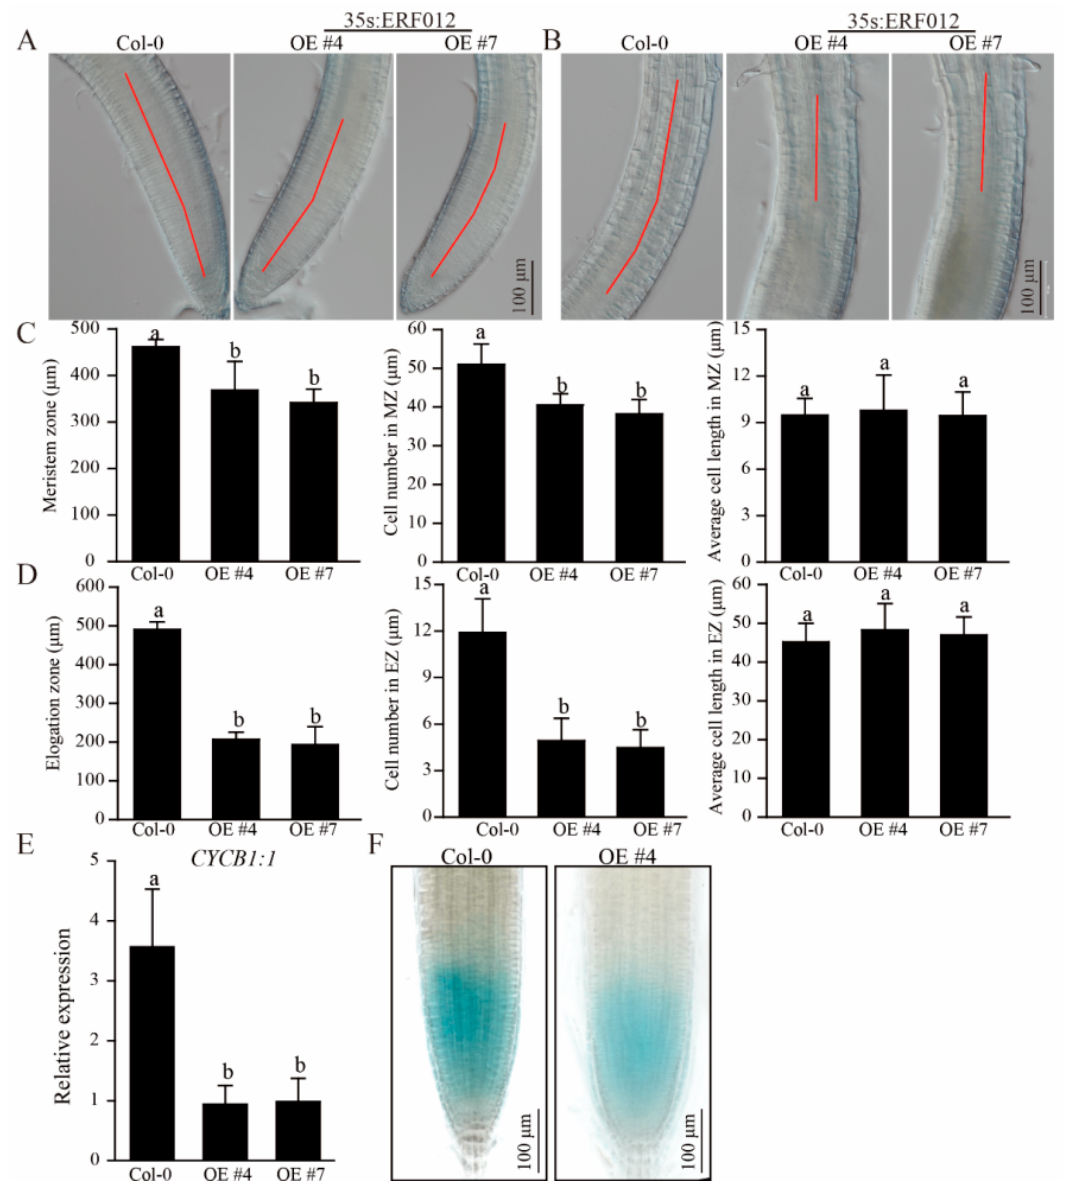
Figure 3. ERF012 involves root cell growth and division. ( A , B ) Root tip images of Col-0 and ERF012 -OE lines. The red lines indicate the meristem zone ( A ) and elongation zone ( B ). ( C , D ) The statistical calculation of zone length, cell number and average cell length in root tips of Col-0 and ERF012 -OE lines; n = 12 roots. Values represent means ± SD. ( E ) The expression of CYCB1:1 in the roots of Col-0 and ERF012 -OE lines. Twelve-day-old seedlings were used. Values represent means ± SD, n = 3 pools, with about 20 plant roots per pool. ( F ) Transcription activity analysis of CYCB1;1 in Col-0 and ERF012 -OE backgrounds expressing the p CYCB1:1 :GUS. Letters in ( C – E ) indicate significant differences between different plants: Duncan’s test ( p < 0.05).